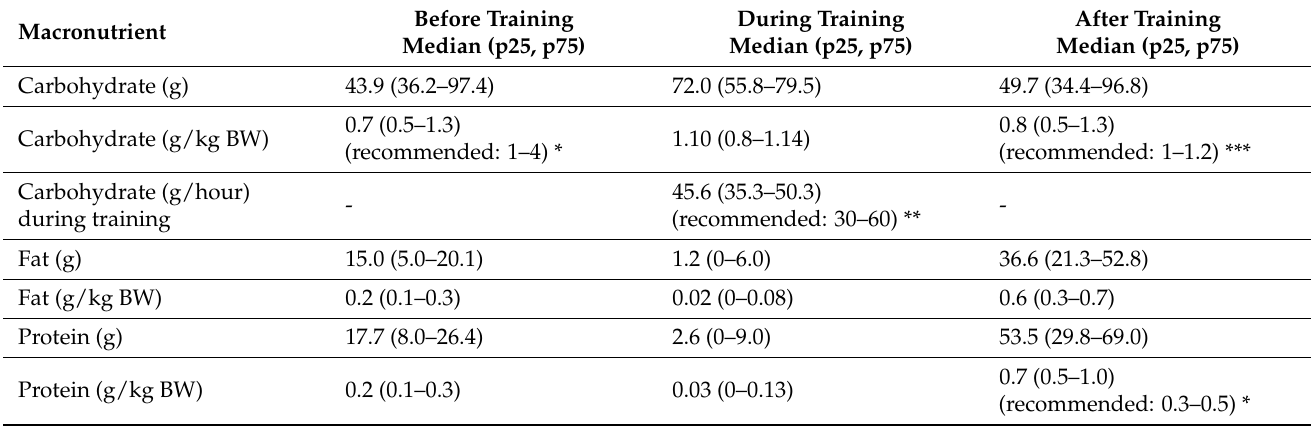
Table 5. Macronutrient intake in relation to training ( n = 10).